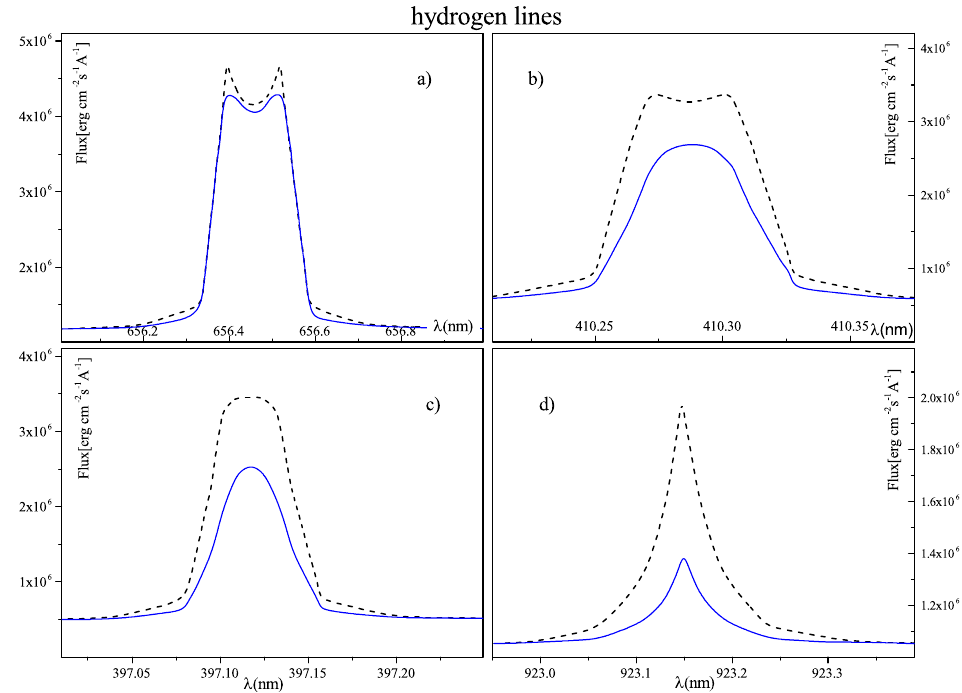
Figure 5. The hydrogen line profiles (( a ) H α ; ( b ) H δ ; ( c ) H (cid:101) ; ( d ) Pa (cid:101) ) in the late type (M) stars’ atmospheres. Dotted black and full blue curves denote lines without and with the inclusion of chemi-ionization and chemi-recombination processes (1),